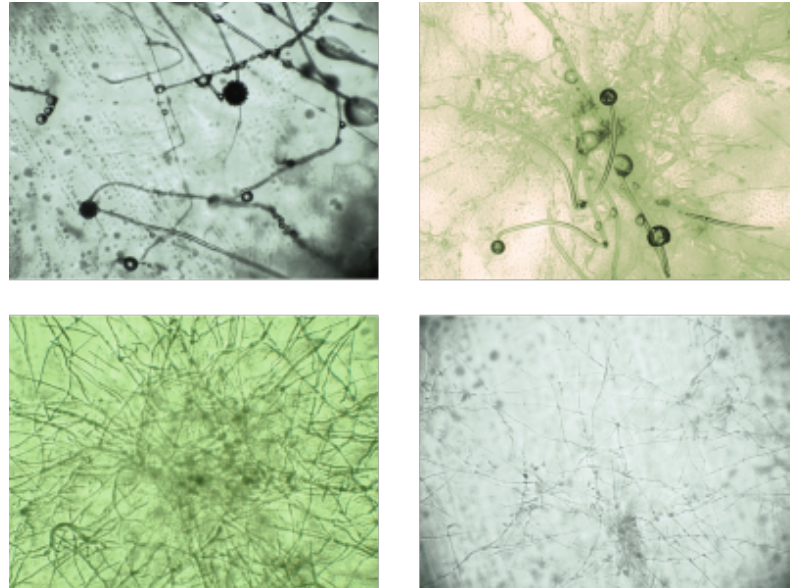
Figure 3. The microscopic images with magnification 100 × after 18 h; the first row Aspergillus plus and Aspergillus minus, the second row Penicillium plus and Penicillium minus. Label